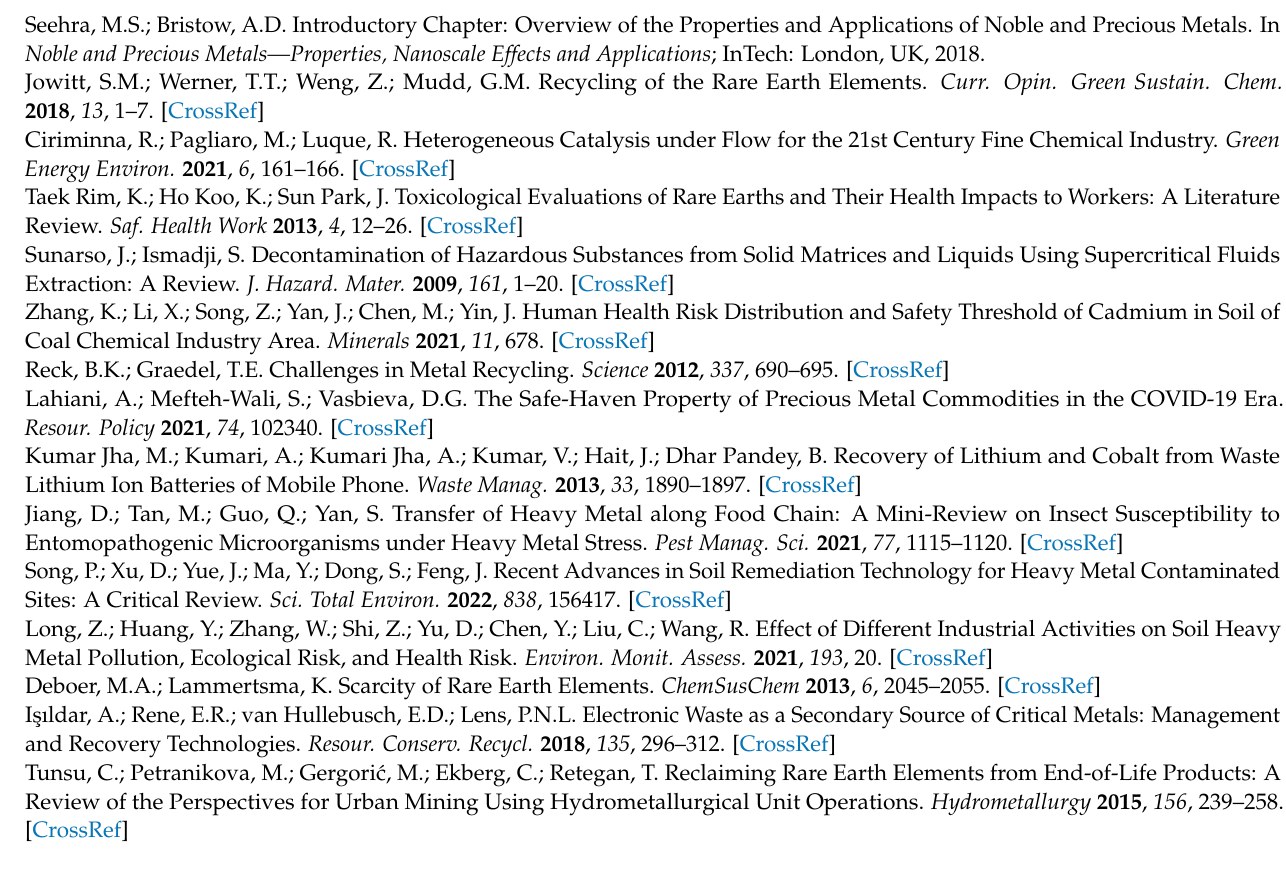
co -FDA)SH; Figure S53: Cloud Point measurement for P(StySAc- co -FDA); Figure S54: Cloud Point measurement for P(StySH- co -FDA)SH; Figure S55: Cloud point curves in dense CO 2 for the synthe- sized polymers; Table S1: Assignments of peaks in P(4VP- co -FDA) copolymer, with n 4VP units and m FDA units; Table S2: Assignments of peaks in P(DPPS- co -FDA), with n DPPS units and m FDA units; Table S3: Assignments of peaks in P(DPPS- co -oxidized DPPS- co -FDA), with n DPPS units, x oxidized DPPS units and m FDA units; Table S4: Assignments of peaks in P(StySAc- co -FDA), with n StySAc units and m FDA